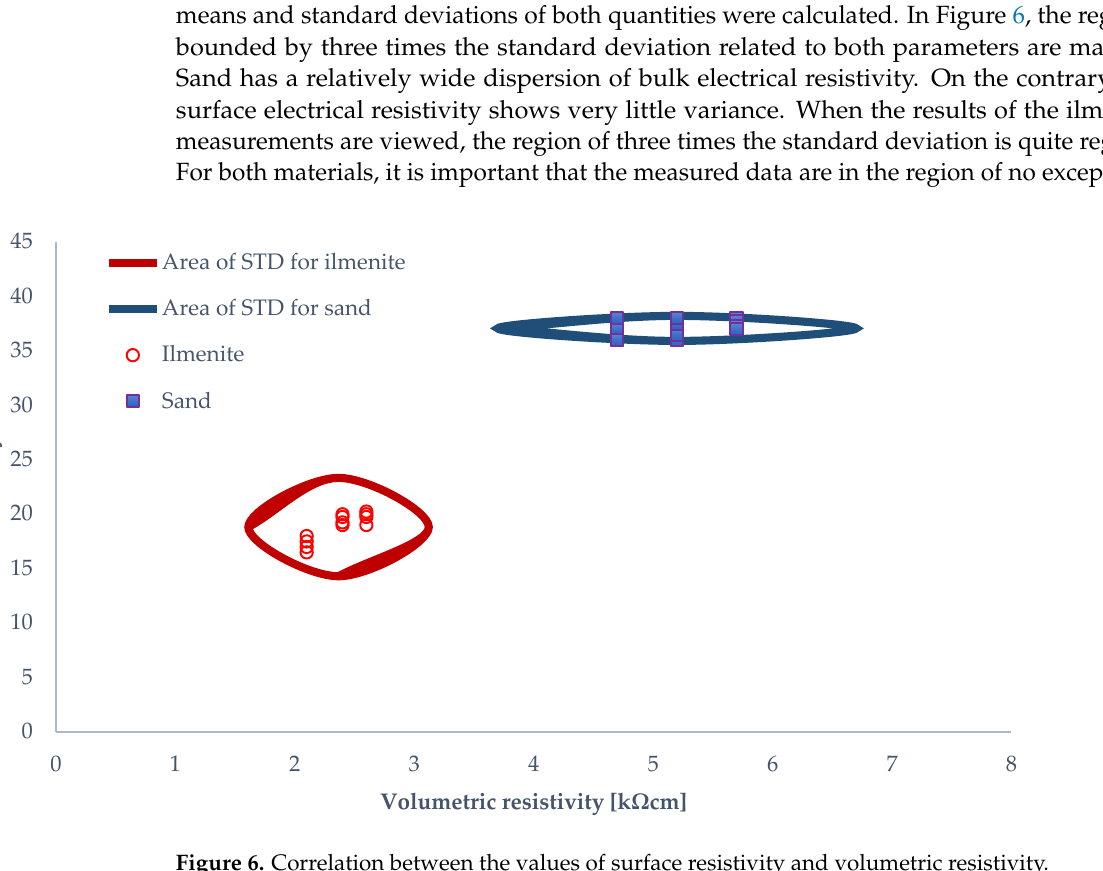
Figure 7. Correlation between the values of volumetric resistivity and compressive strength. As a final result, Figure 8 shows the correlation and standard deviation region for bulk resistivity and density. Ilmenite has a lower resistivity despite the higher density. All the graphs show that the mortar made of sand and ilmenite behaves differently.